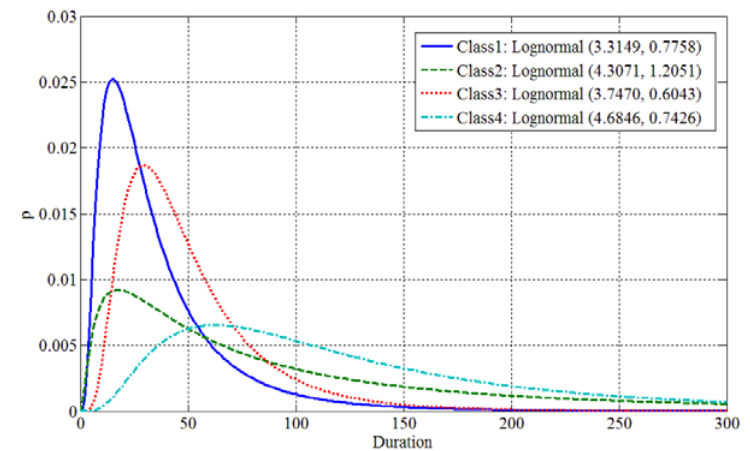
Fig. 3. The distribution of Duration for each class.